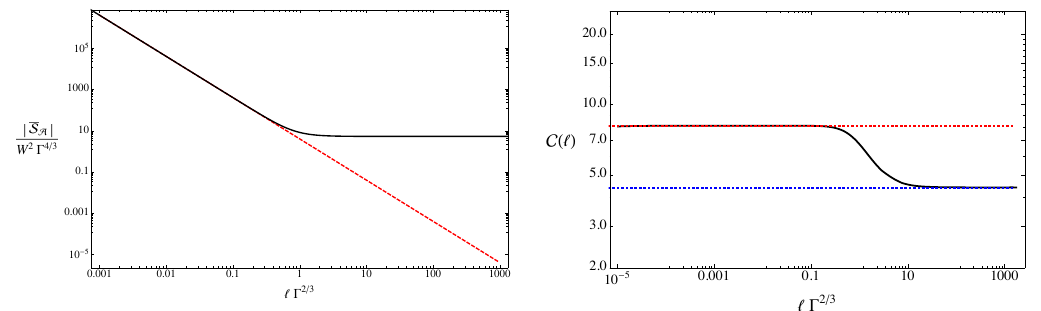
Figure 4 . The entanglement entropy (cid:22) S A (left) and entropic c -function C ( l ) (right) evaluated in the AdS 0 ! AdS c domain wall (cid:13)ow. The pure AdS 0 5 5 agree excellently with the numerically computed quantities for small values of l . The right plot shows that the entropic c -function C ( l ) monotonically approaches the result for pure AdS c dashed, blue line) for large l